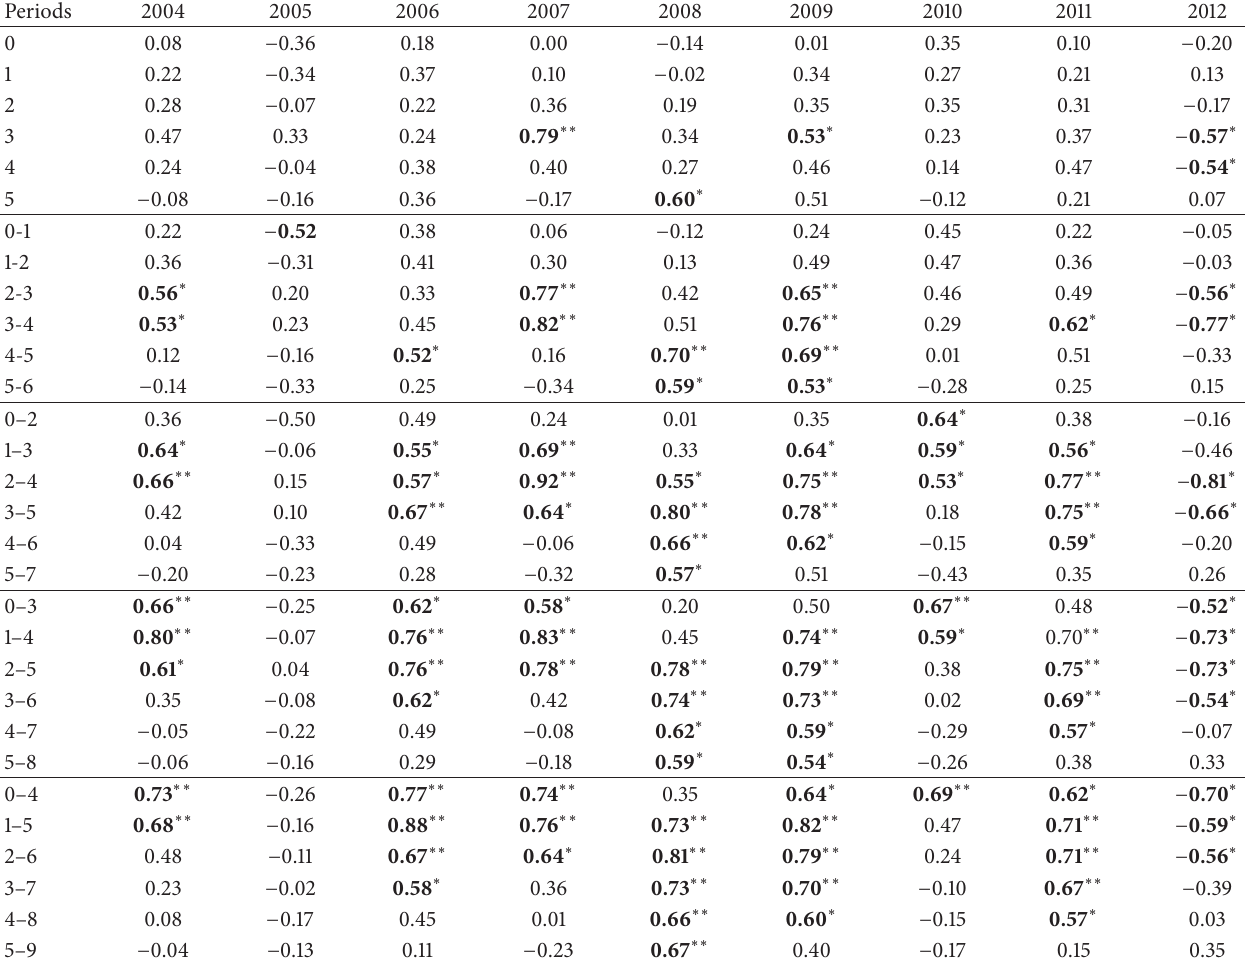
Table 2: Within-season correlation coefficients between precipitation and NDVI of the shrubland within Gurbantunggut Desert. The numbers in the first column indicated the time interval for which precipitation is accumulated (0 indicated the current 16-day period, 1 indicated the first previous period, 0-1 indicated from current period to first previous period,